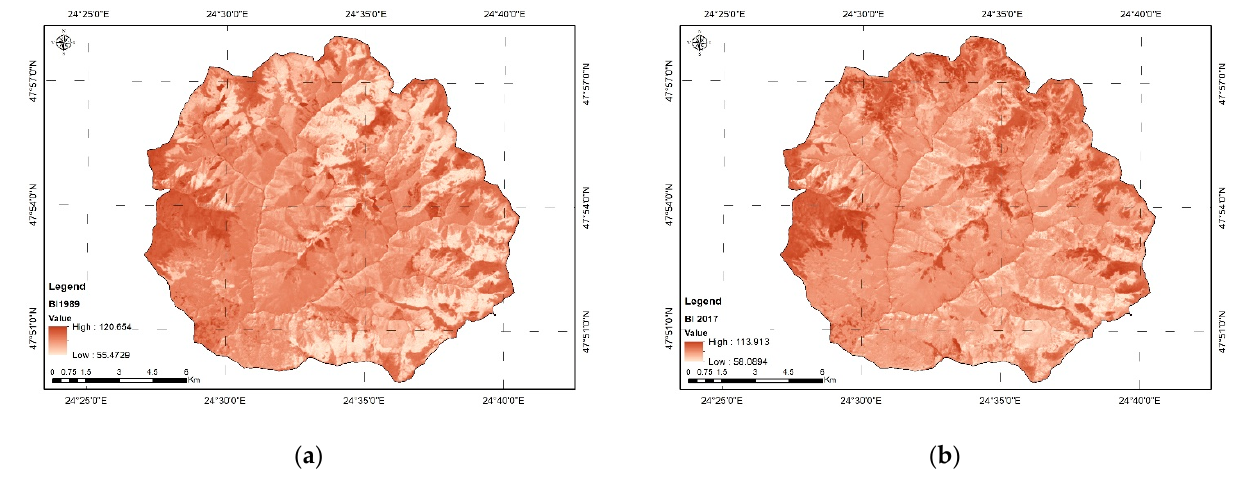
Figure 5. Bar soil index (BI). ( a ) BI for year 1989; ( b ) BI for year 2017 where: Shadow Index (SI). The use of this index highlights the three-dimensional character- istics of the forest by placing the focus on the shaded areas of the forest canopy. It is based on the low brightness of the visible bands. Through this process, younger tree structures